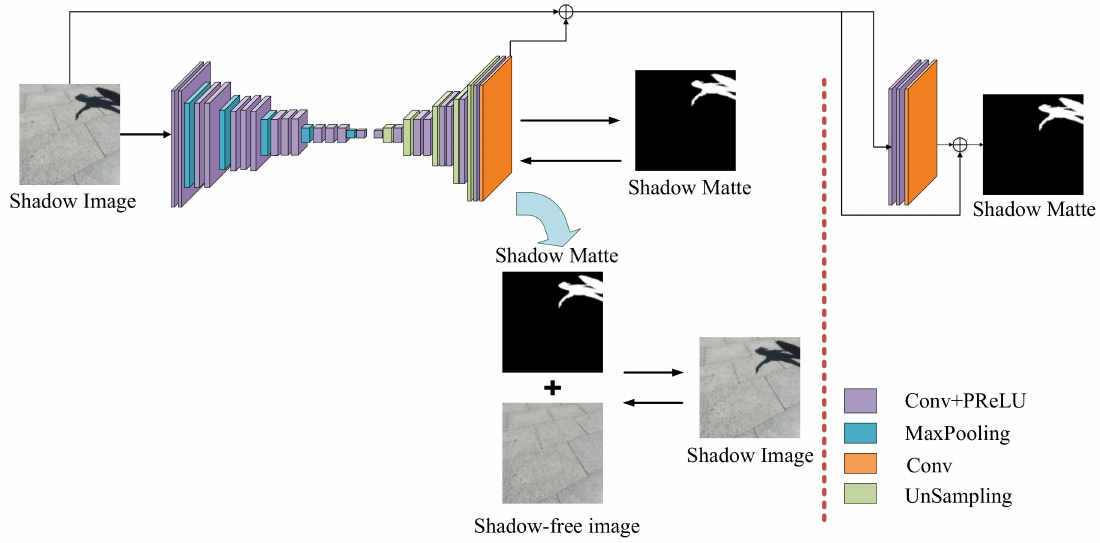
Figure 1. The architecture of the RSnet. RSnet consists of two cooperative sub-networks. The left side of the dotted line shows the encoding–decoding network, and the right side shows the refinement